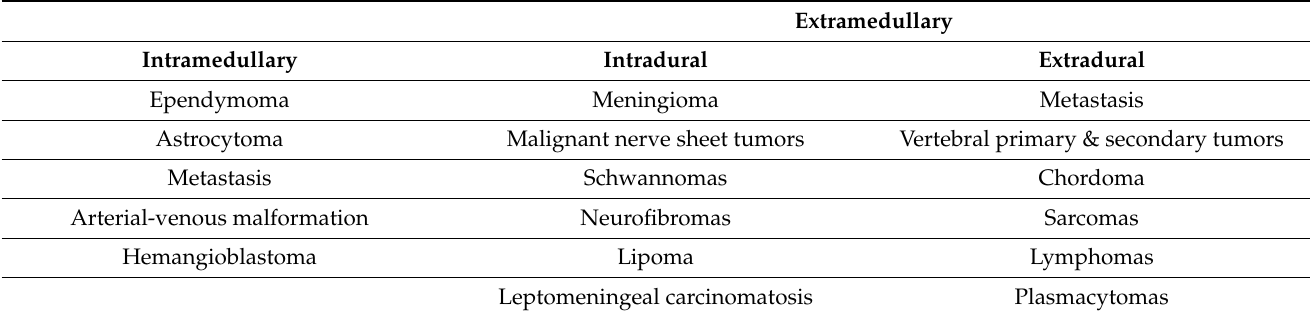
Table 2. Intramedullary and extramedullary tumors and their locations.